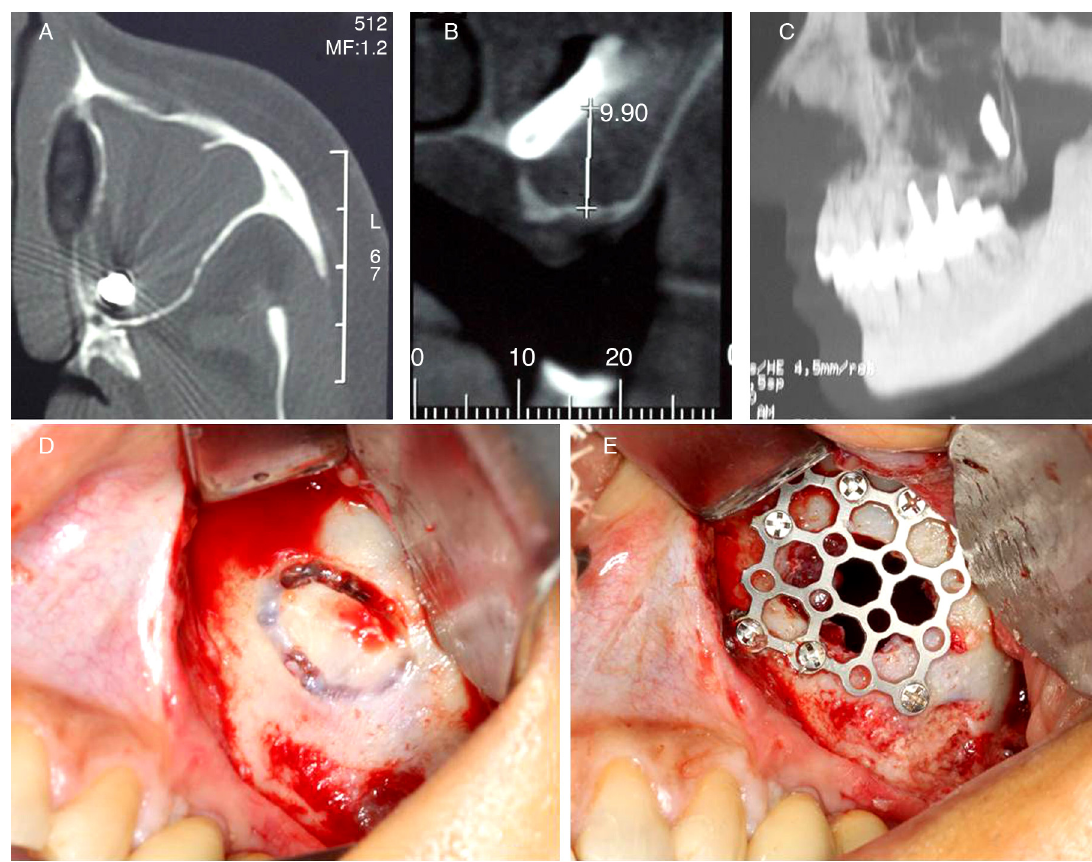
(A) TC axial, (B) TC coronal, (C) TC sagittal, (D) Calwell-Luc approach and (E) reconstruction of the sinus anterior wall with a titanium